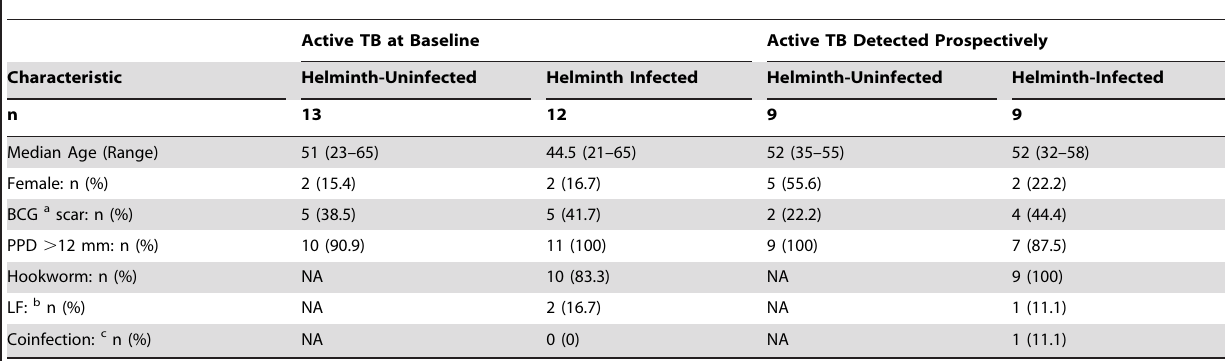
a Bacillus Calmette-Gue´rin. b Lymphatic filariasis (circulating filaria antigen). c LF and hookworm. doi:10.1371/journal.pone.0094603.t002 PLOS ONE |